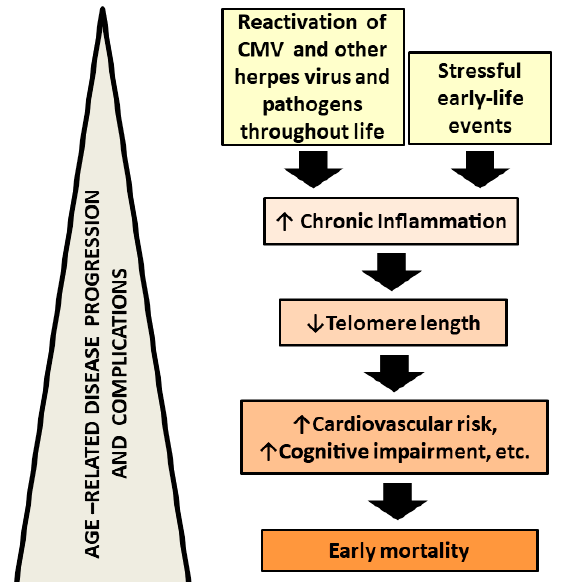
Figure 2. Possible mechanisms involved in schizophrenia associated early ageing. Reactivation of pathogens, such as Cytomegalovirus (CMV), involved in chronic inflammation together with other stressful events and genetic vulnerability can be considered etiological factors for schizophrenia and other mental diseases. Chronic inflammation induces telomere shortening that is related to increased cardiovascular risk and cognitive impairment altogether involved in early mortality in schizophrenia patients.